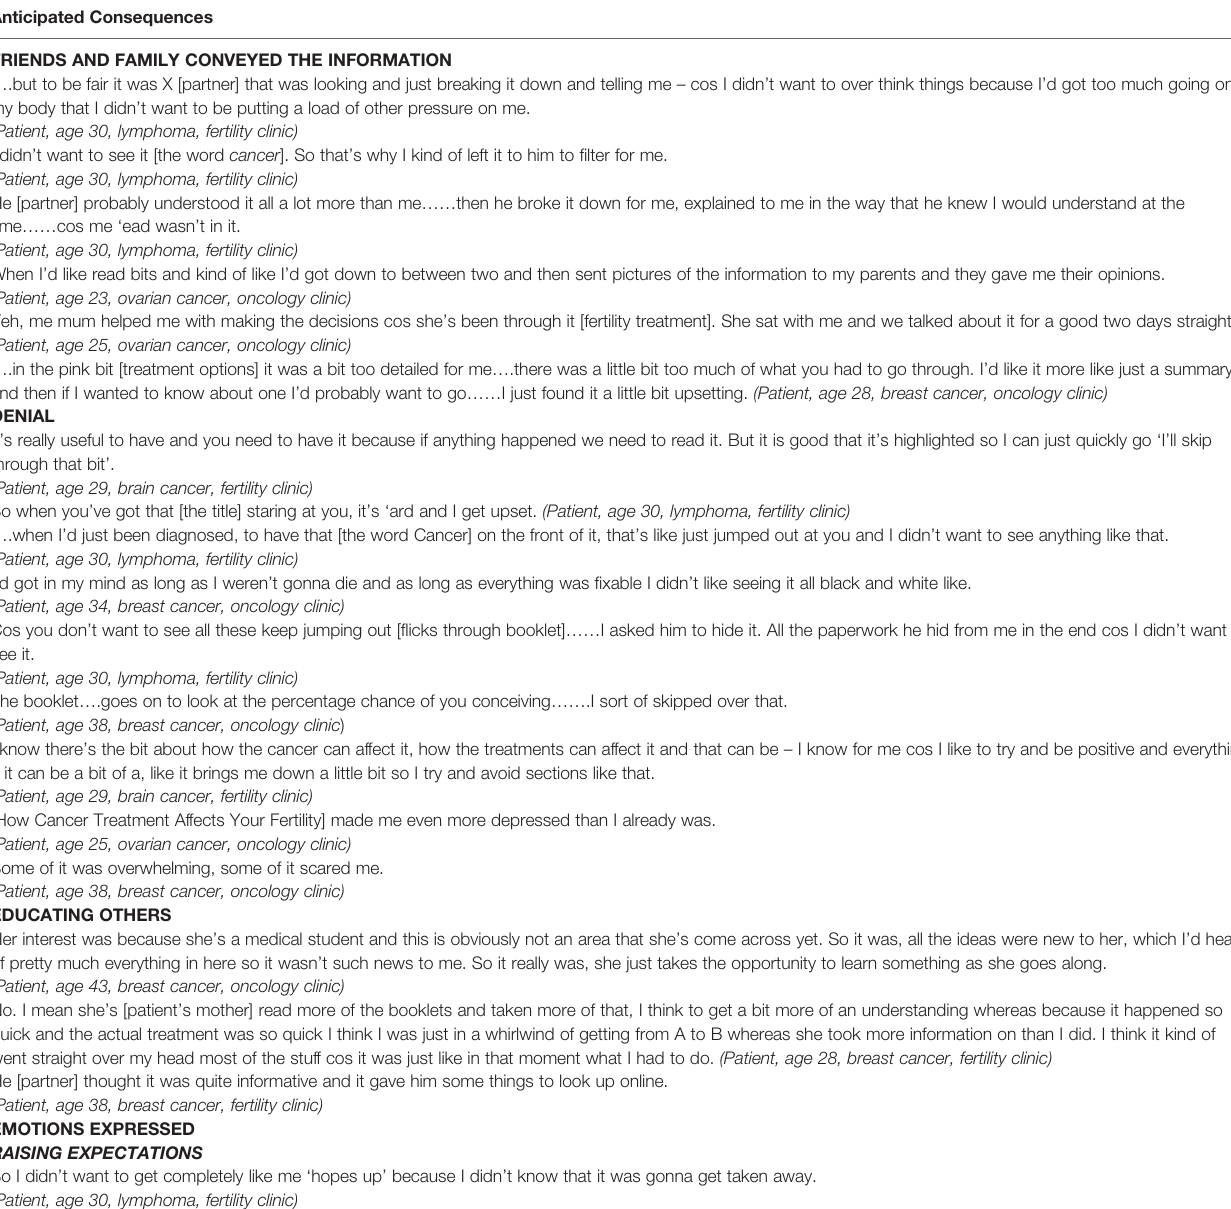
TABLE 7 | Anticipated consequences of using